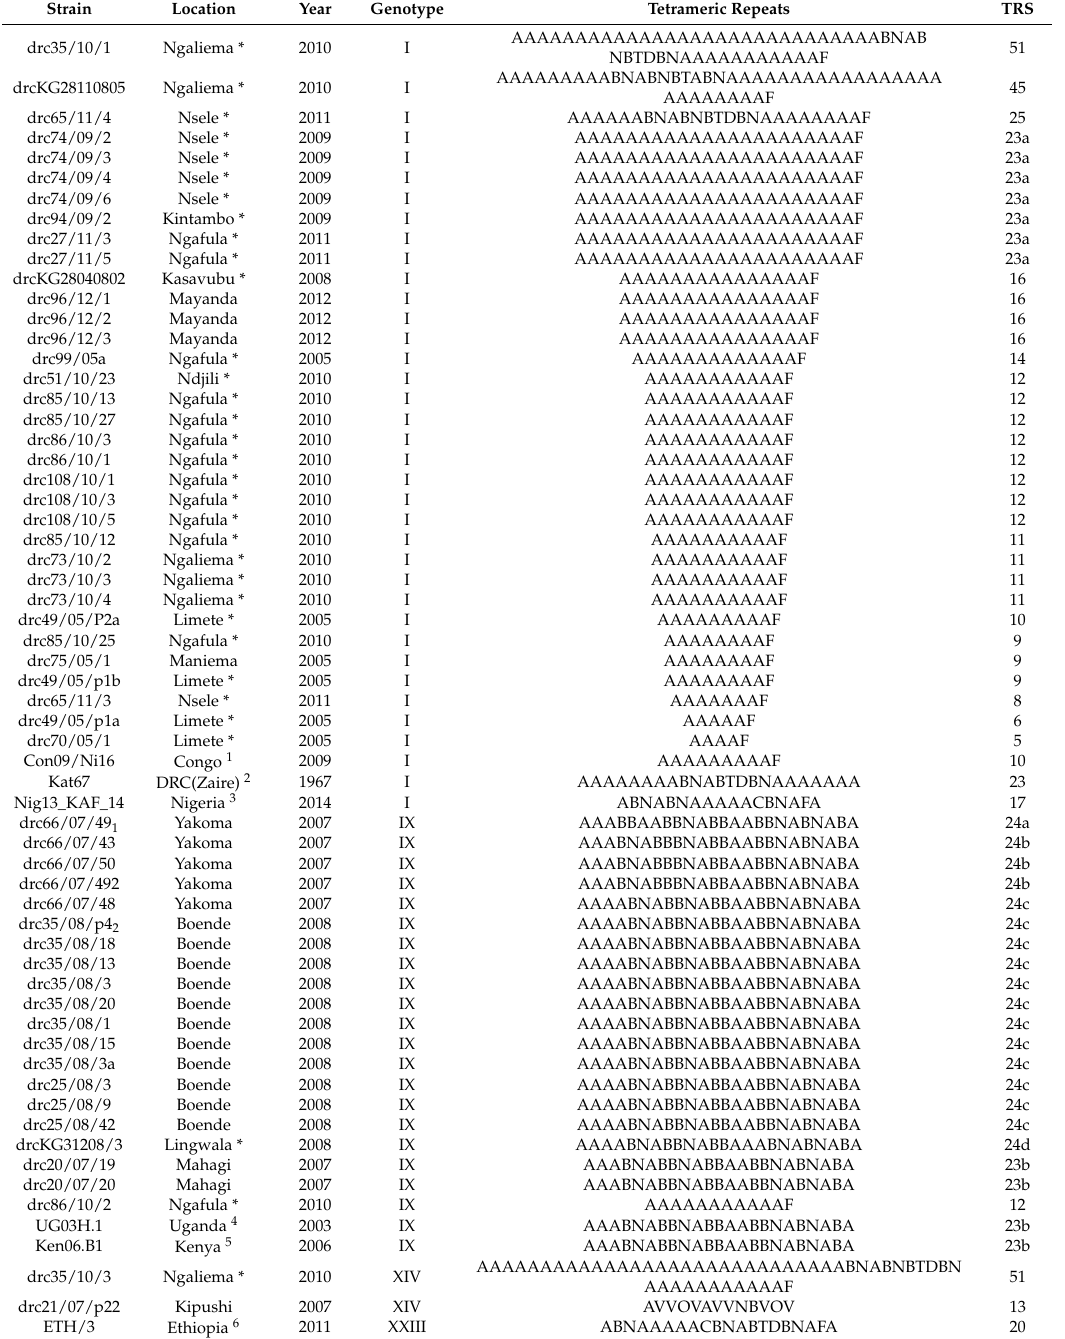
Table 2. Central hypervariable region (CVR) locus-based intra-genotype